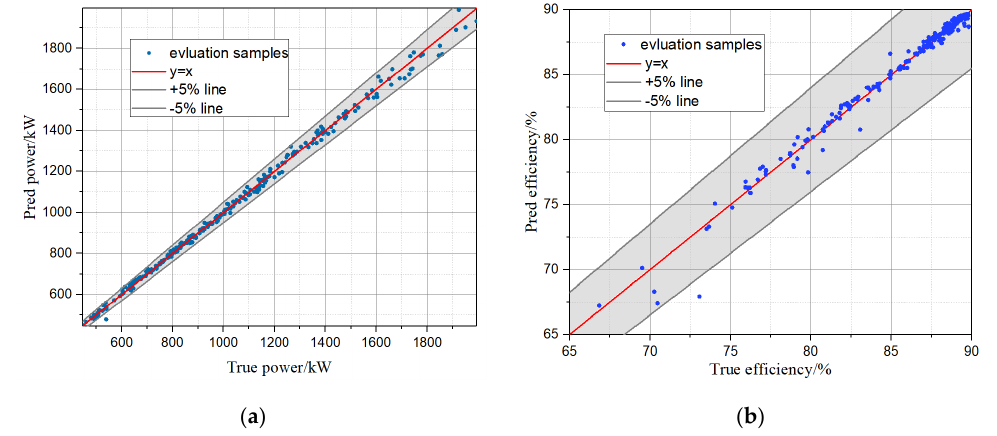
Figure 13. True-pre performance curve: ( a ) power; ( b ) efficiency.